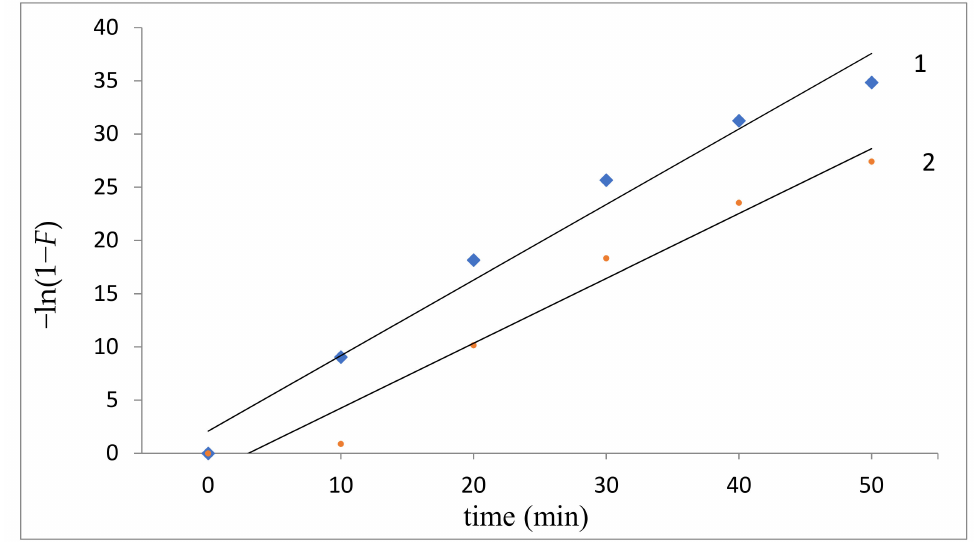
Figure 11. Dependence of − ln (1 − F ) on sorption time of fluoride ions (1-sorbent layer thickness 50 nm; 2-sorbent layer thickness 100 nm).